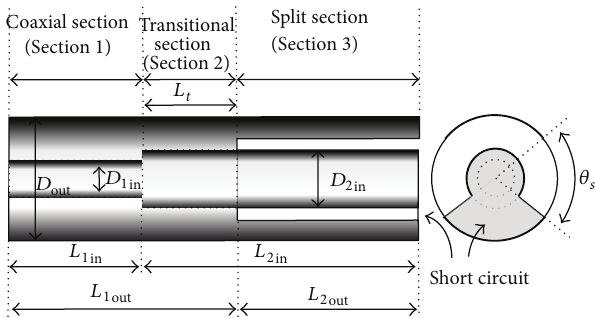
Figure 2: Dimensional parameters of the split coaxial balun.